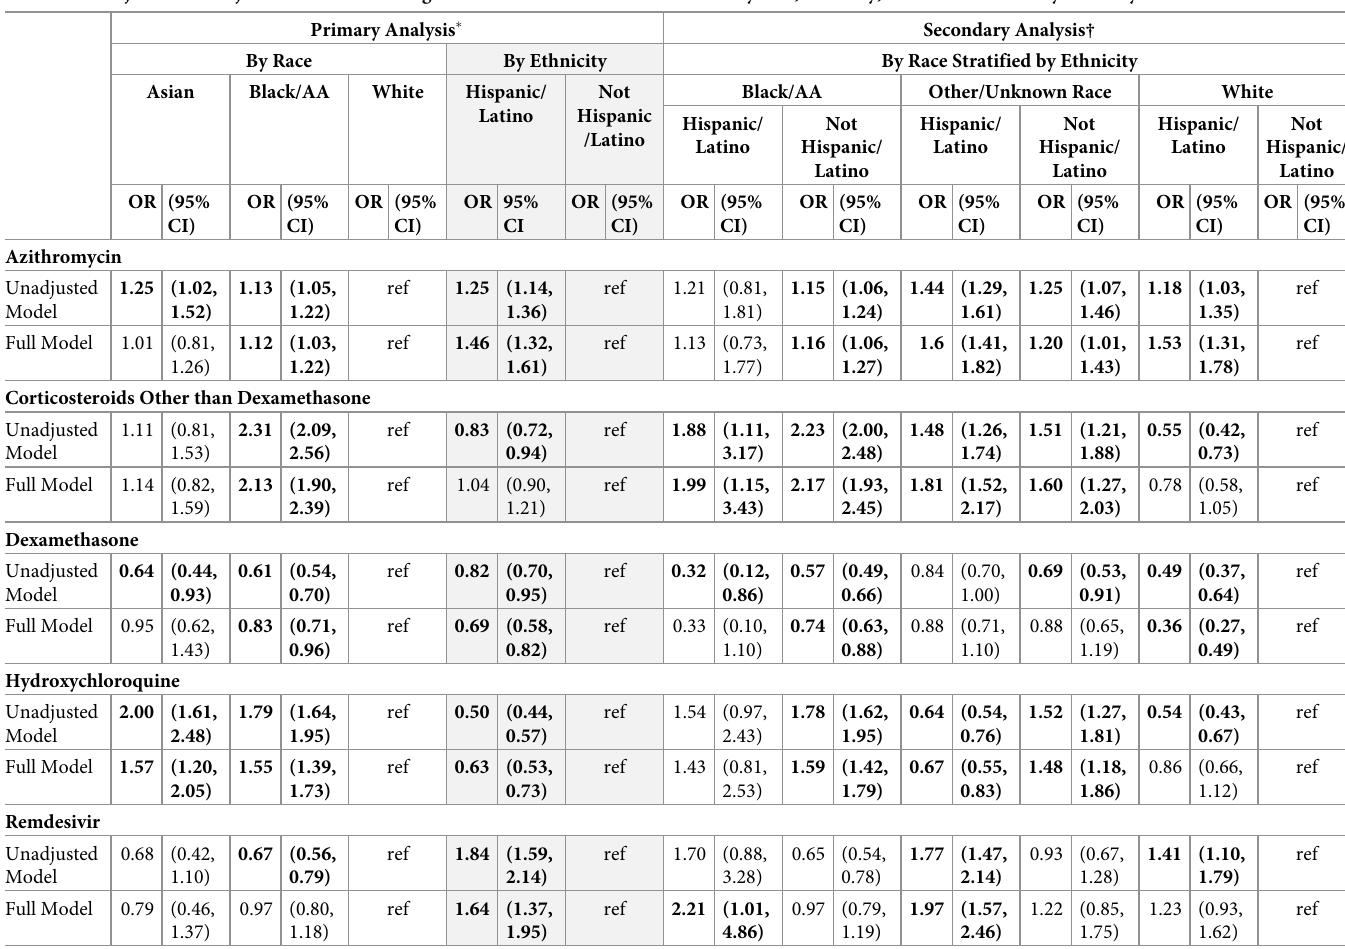
Table 3. Unadjusted and adjusted odds of receiving COVID-19 treatments at admission by race, ethnicity, and race stratified by